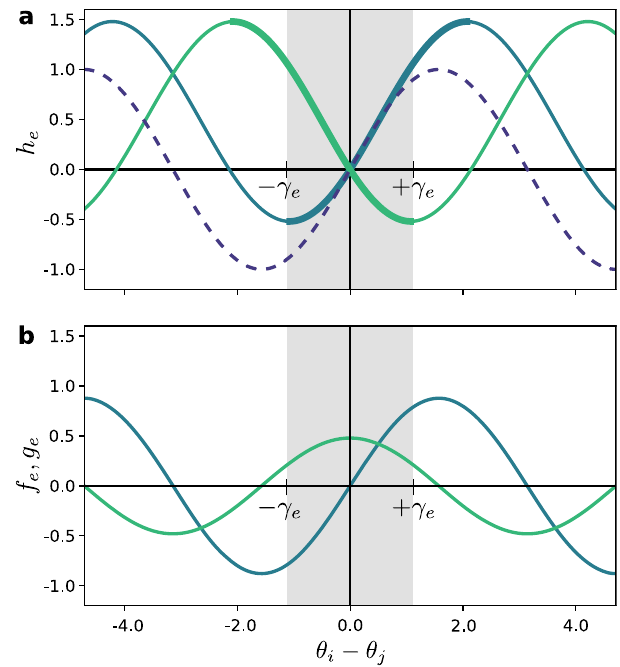
Fig.5|CouplingfunctionsfortheKuramoto – Sakaguhchimodel.a Comparison between coupling functions for Kuramoto [dashed dark blue, h e ð x Þ = sin ð x Þ ] and Kuramoto – Sakaguchi [plain cyan, h e ð x Þ = sin ð x (cid:2) ϕ Þ + sin ð ϕ Þ ], with ϕ =0.5. The light green curve illustrates the coupling on the same edge, but with opposite orientation [ h (cid:2) e ð(cid:2) x Þ = sin ð(cid:2) x (cid:2) ϕ Þ + sin ð ϕ Þ ]. The thick parts (cyan and green) emphasize the region where the curve isincreasing (resp. decreasing). The shaded gray area shows the interval where the coupling in both orientations is strictly monotone. b Odd (cyan) and even (green) parts of the Kuramoto – Sakaguchi cou- pling function, as de fi ned in equation